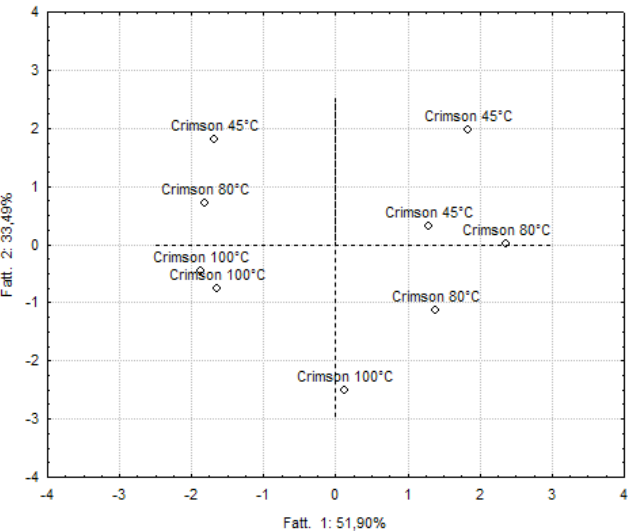
Figure 4. Principal component analysis applied to Crimson grape-based